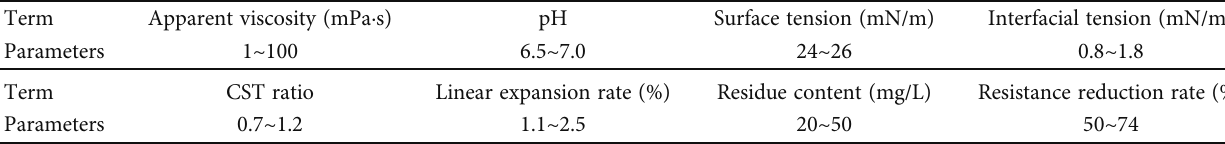
Table 1: Performance parameters of slickwater.